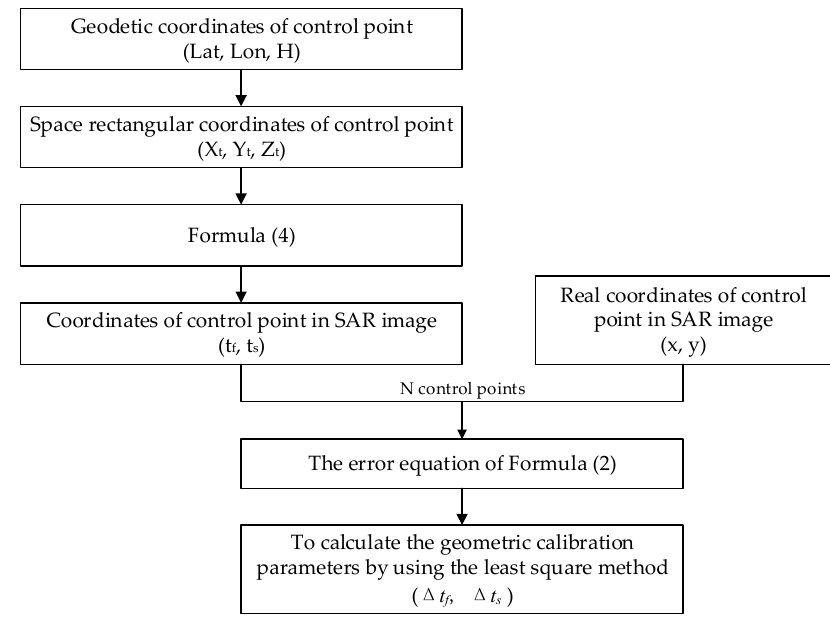
Figure 1. Flow chart of geometric calibration algorithm.